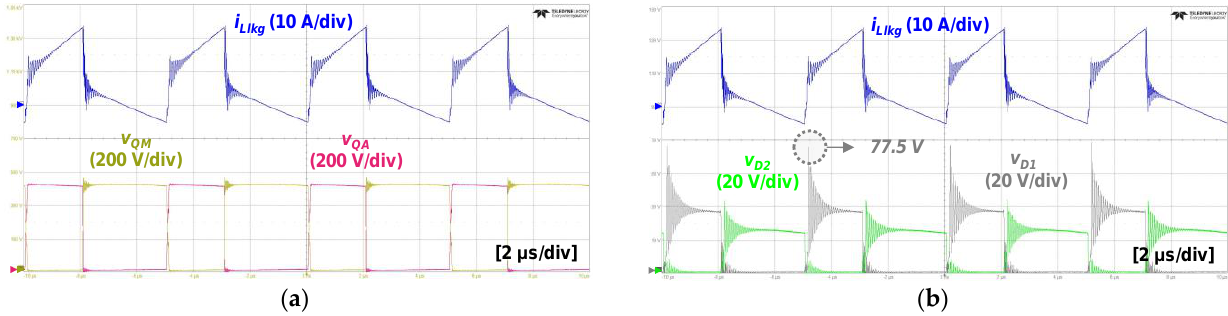
Figure 16. Key experimental waveforms at 310 V input and 100% load conditions: ( a ) Primary side key experimental waveforms. ( b ) Secondary side key experimental waveforms.